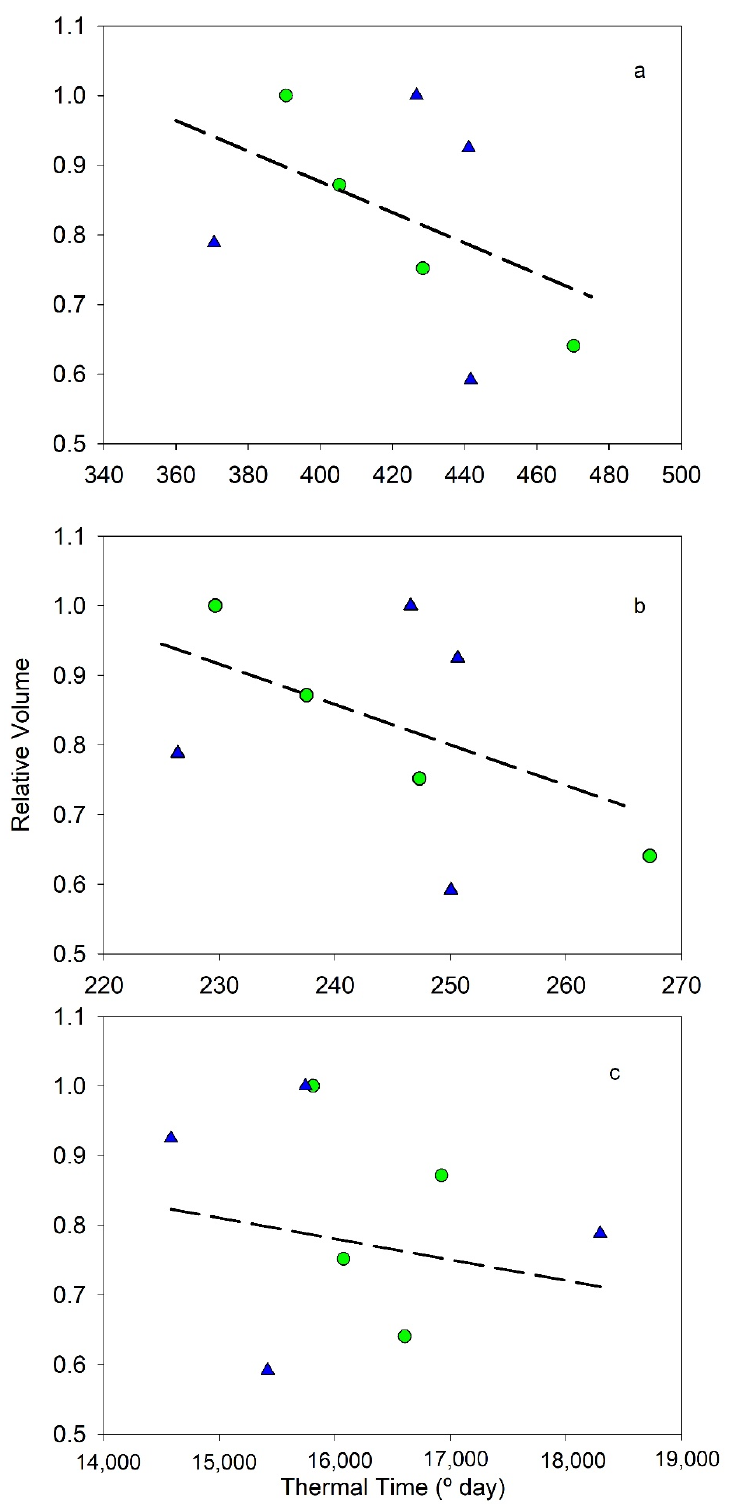
Figure 1. Relationship between relative fruit weight at the end of Period I of endocarp development and the three thermal time models ( a ) Lineal, ( b ) Exponential, ( c ) Cosine. Green circle, cv Cor- nicabra; blue triangle, cv Arbequina. Lines represent the best fit using all data. Each weight data are the average of the values obtained in each season.